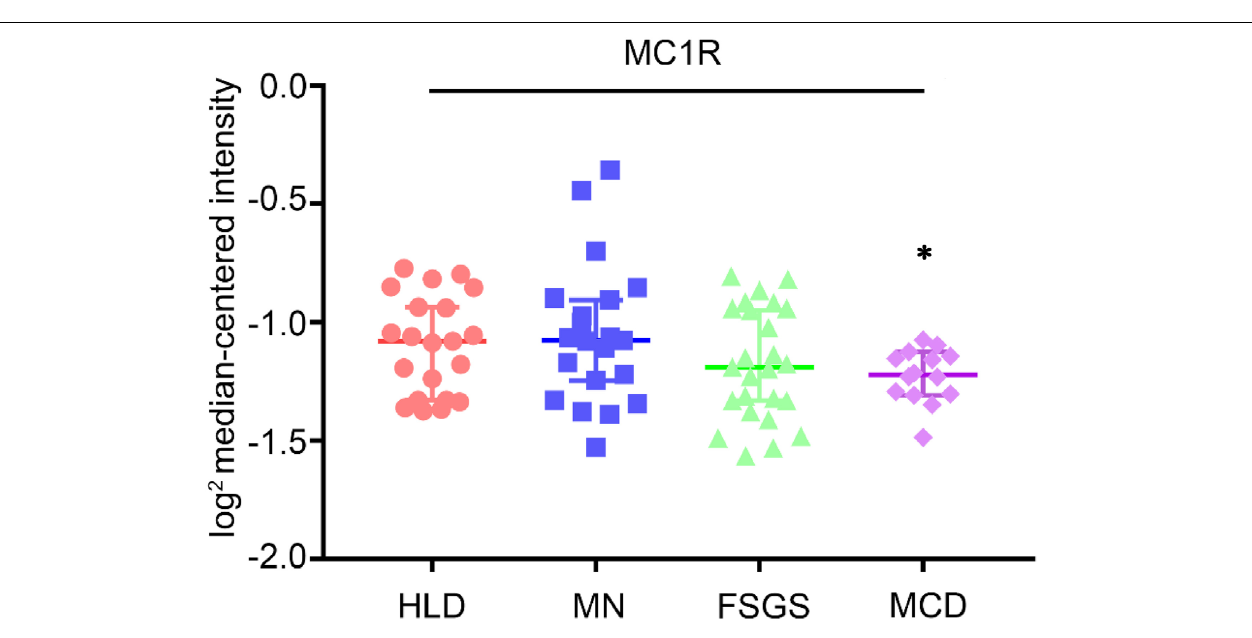
FIGURE 5 | Expression levels of MC1R mRNA in glomeruli procured from healthy living donors and patients with diverse glomerular disease. Data were derived from www.Nephroseq.org on the basis of the Ju CKD Glom dataset. Glomerular expression of MC1R mRNA is not altered in glomerular diseases. Minimal Change Disease vs. Healthy Living Donor, ∗ P -value: 0.011. Focal Segmental Glomerulosclerosis vs. Healthy Living Donor, P -value: 0.111. Membranous Glomerulonephropathy vs. Healthy Living Donor, P -value: 0.697. HLD, healthy living donor; MN, membranous glomerulonephropathy; FSGS, focal segmental glomerulosclerosis; MCD, minimal change